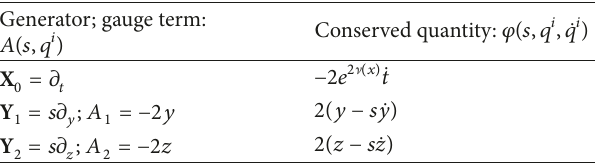
Table 31: Conserved quantities corresponding to each Noether